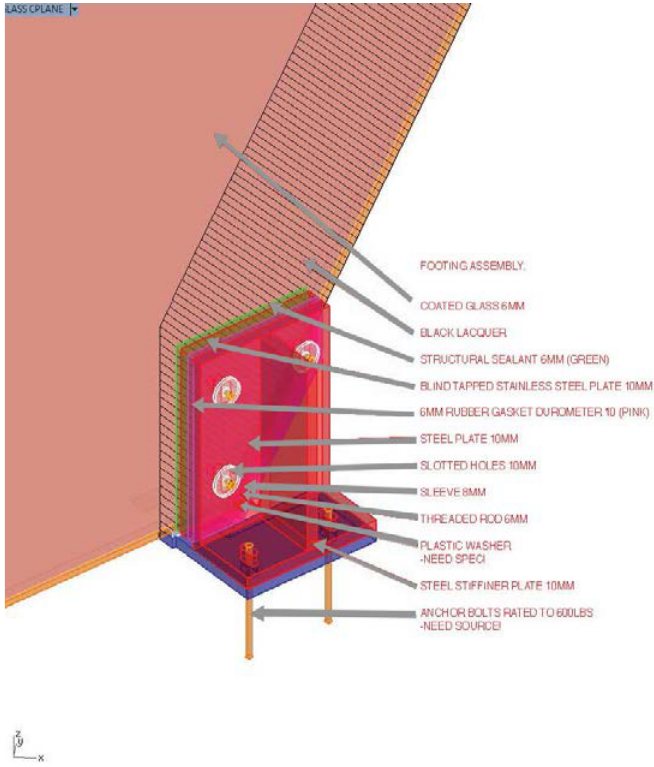
Fig. 19 33-D, 2014 | Concealed base support (rear) Rendering courtesy of Sarah